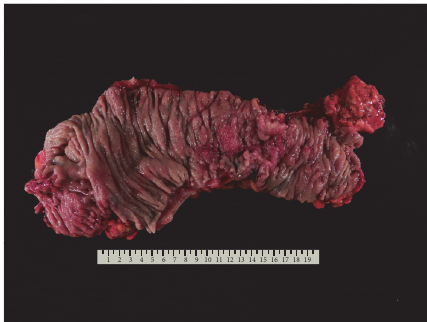
Figure 3: Pathologic specimen after surgical resection for the cecal